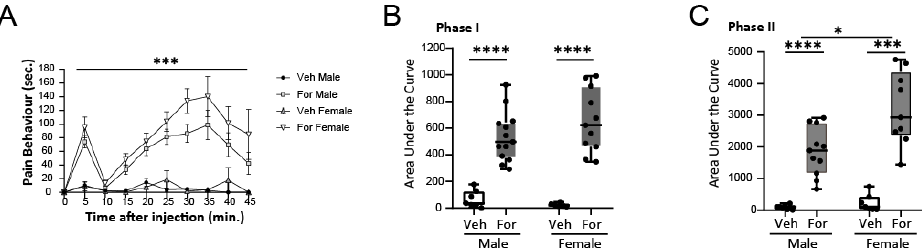
Figure 1. Response to formalin test in 8-week-old mice. ( A ) Pain behavior (in seconds) at different time points after formalin (For) male (white squares) and female (triangle facing down), or Veh male (black squares) and female (triangle facing up) -injected mice). ANOVA repeated measures, *** p < 0.001. Area under the curve for Phase I ( B ) from 0 to 15 min or Phase II ( C ) 15 to 45 min of the For or Veh test described in ( A ) in females and males ( C ). Two-way ANOVA, **** p < 0.0001; * p < 0.05.